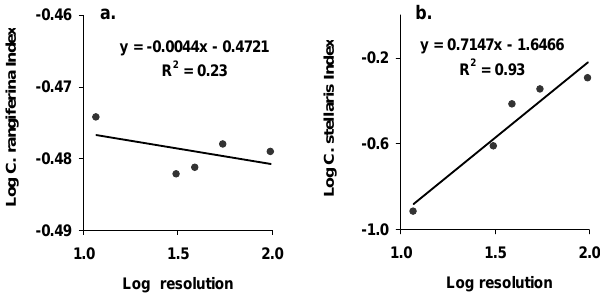
Fig. 7 – Up-scaling the new spectral indices; the log of the spectral indices C. rangiferina and C. stellaris are plotted against the log of the spatial resolution, in site 106 on August 12 th , 2007 (n = 5, significance level < 0.05, and critical value R 2 > 0.65).